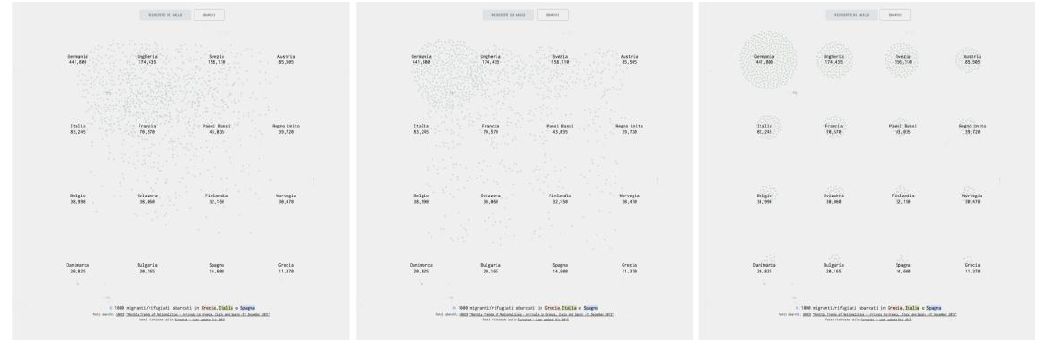
Figure 6. Three frames of the same animation . The dots that were forming the million-refugees cloud, relocate on a grid, forming a series of 16